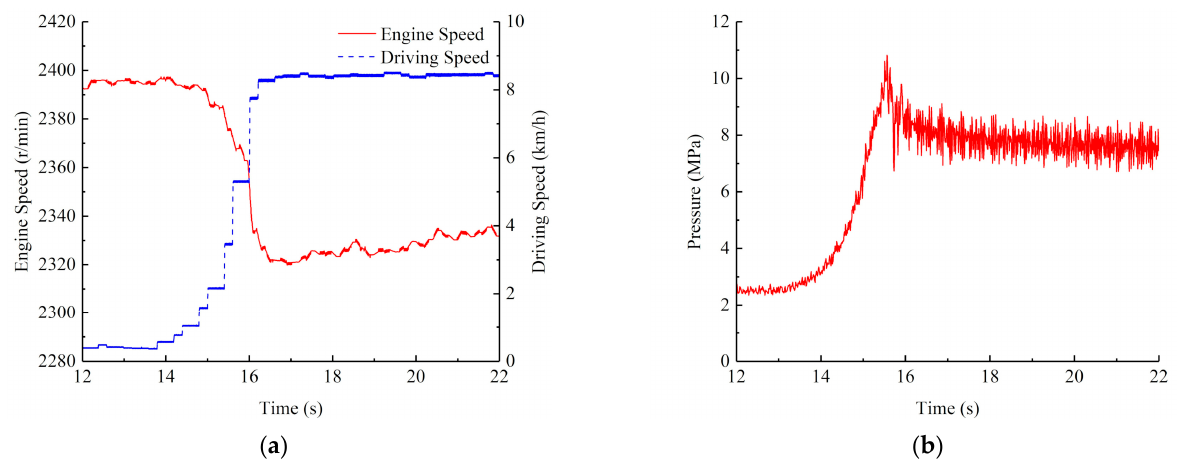
Figure 12. Parameters when starting on flat ground in Gear III: ( a ) change of the engine speed and driving speed; ( b ) change if the inlet and outlet pressure difference of the hydraulic motor.